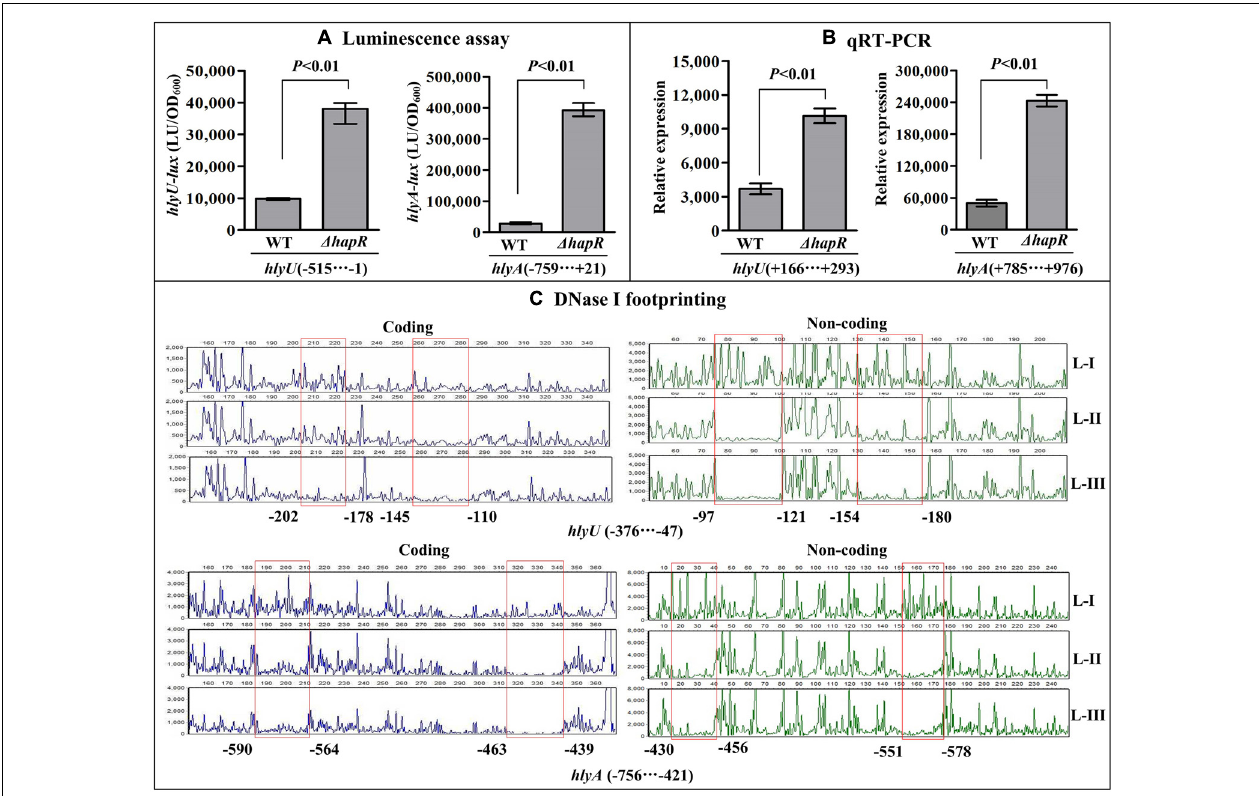
FIGURE 4 | Negatively regulation of hlyU and hlyA by HapR. The luminescence assay (A) was done as Figure 2 . The qRT-PCR (B) and DNase I footprinting assay (C) were done as Figure 3 . Lanes-I, II, and III contain 0, 2.31, and 6.92 pmol His-HapR, respectively.